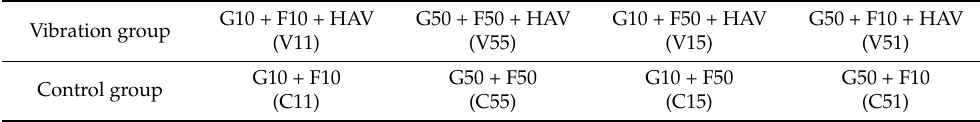
Table 1. The eight force-and-vibration situations experienced by subjects. Vibration group